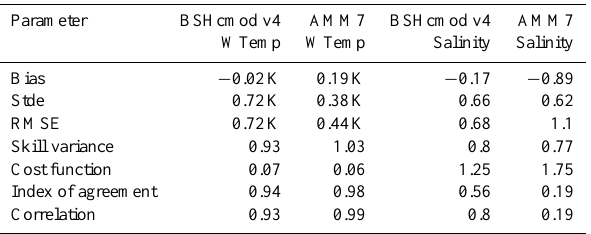
Table 1. Statistical measures for performance analysis of BSHcmod v4 and